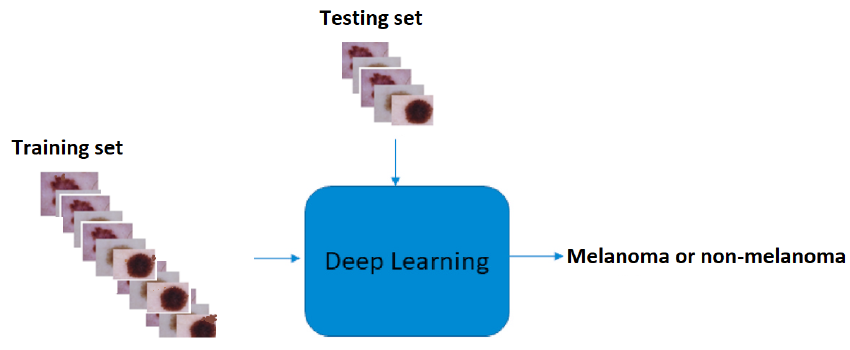
Figure 3. The computational deep learning framework for distinguishing between melanoma skin cancer images and non-melanoma skin cancer images. Skin cancer images from